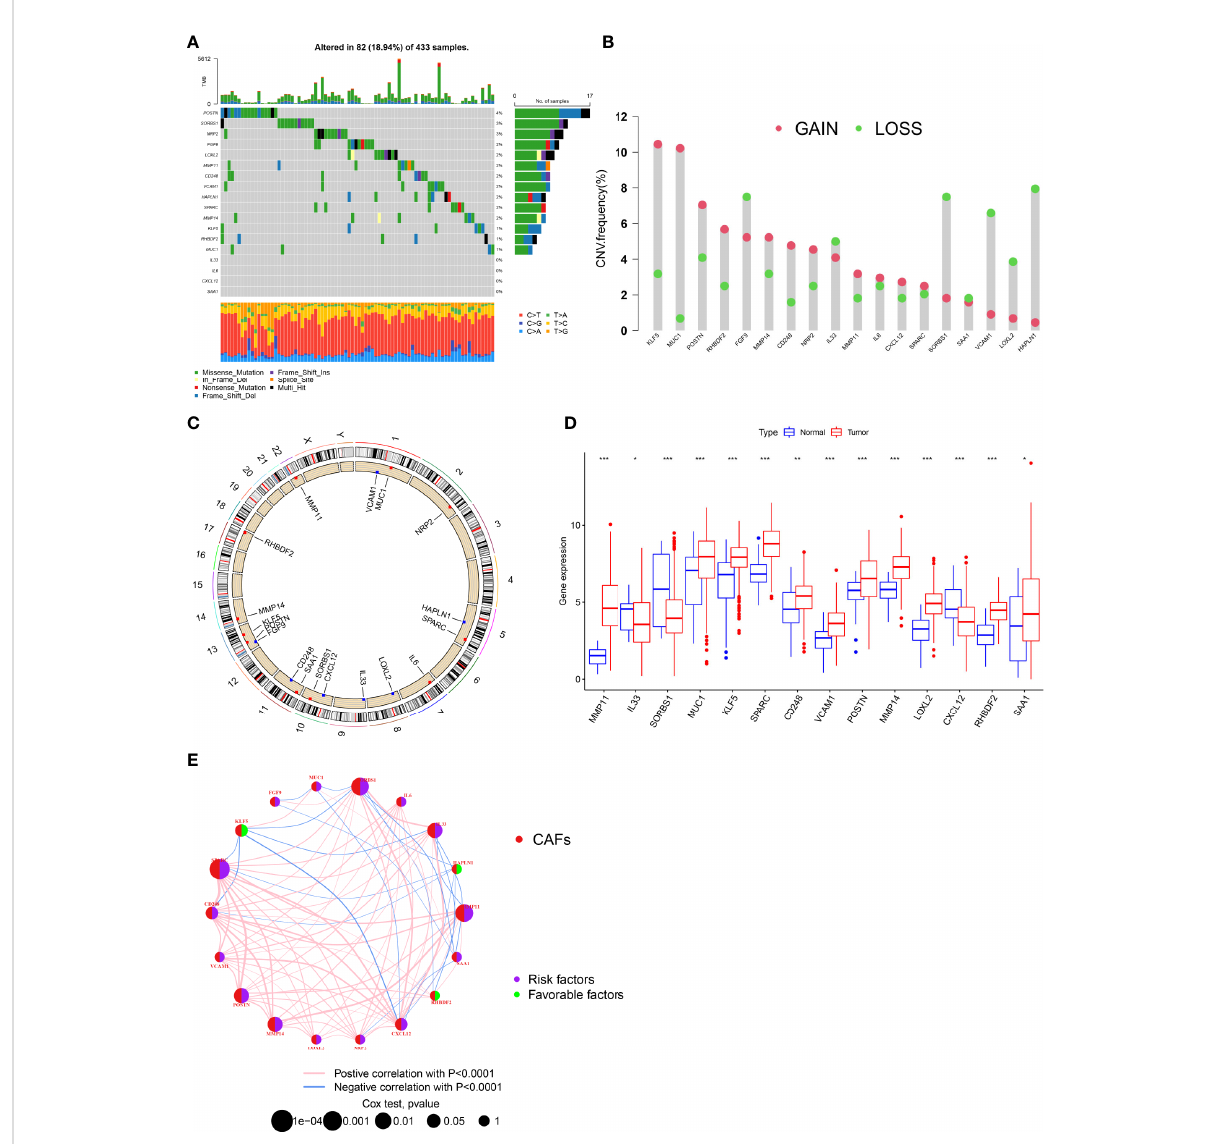
FIGURE 1 Genetic andtranscriptional alterations ofCAFs-related genes in GC. (A) Mutation frequencies of 18CAFs-related genes in 433 patients with STAD from the TCGA cohort. (B) Frequenciesof CNV gain, loss, and non-CNVamong CAFs-related genes. (C) Locations of CNV alterations in CAFs-related genes on23 chromosomes. (D) Expressiondistributions of 1 8 CAFs-related genes in normal and GC tissues. (E) Interactions amongCAFs-related genes in GC. The connectingline amongCAFs-related genes indicates theirinteraction, and the thickness of lines represents the strength of the association between CAFs-related genes. Blue and pink represent negative andpositive correlations, respectively. *P<0.05, **P<0.01,